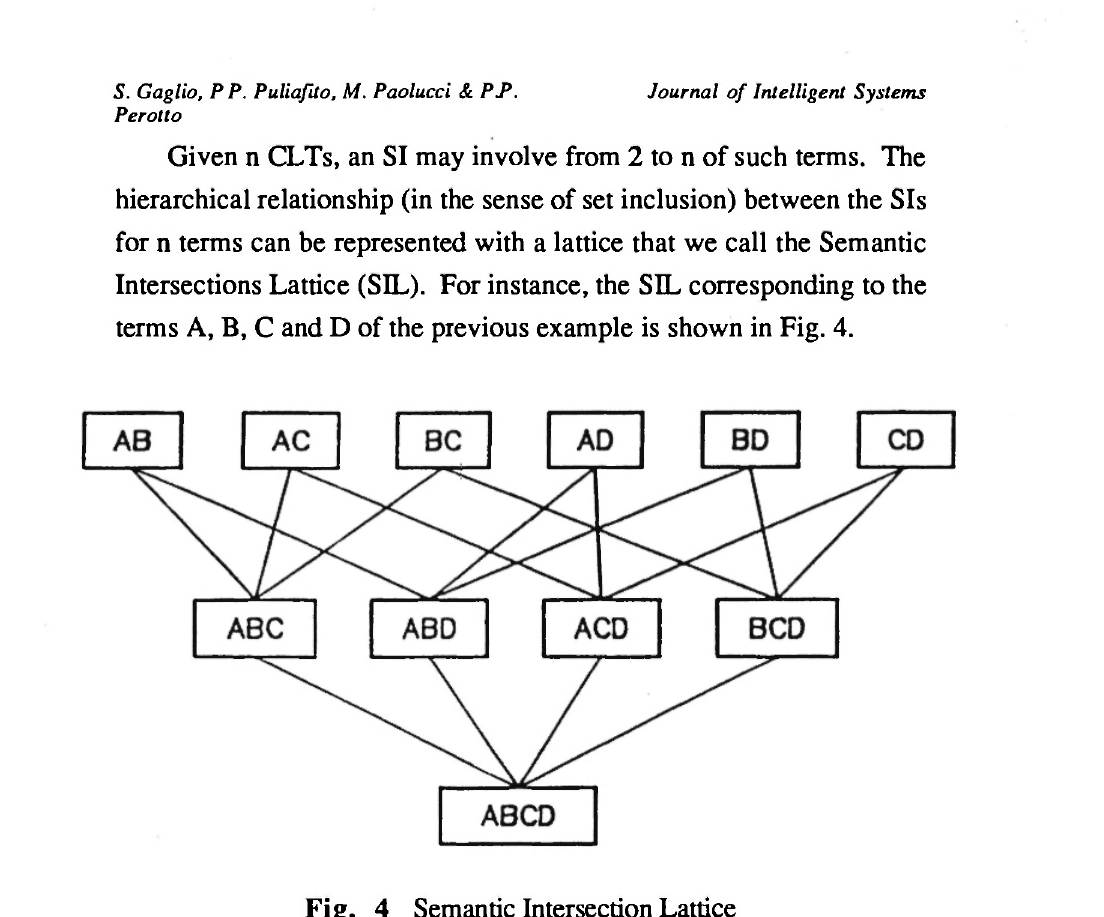
Semantic Intersection